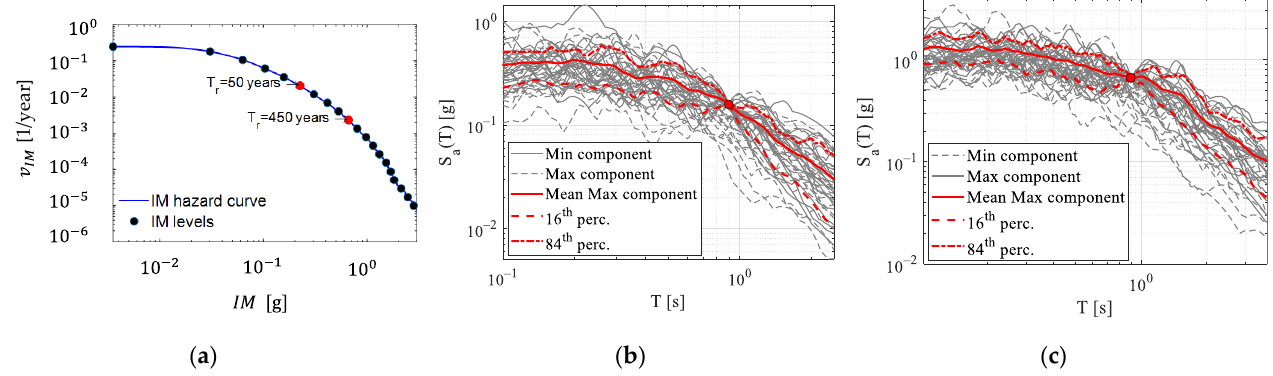
Figure 5. ( a ) IM hazard curve and relevant IM levels; response spectra of the horizontal components of seismic samples at two intensity levels; ( b ) Tr = 50 years; ( c ) Tr = 450 years.